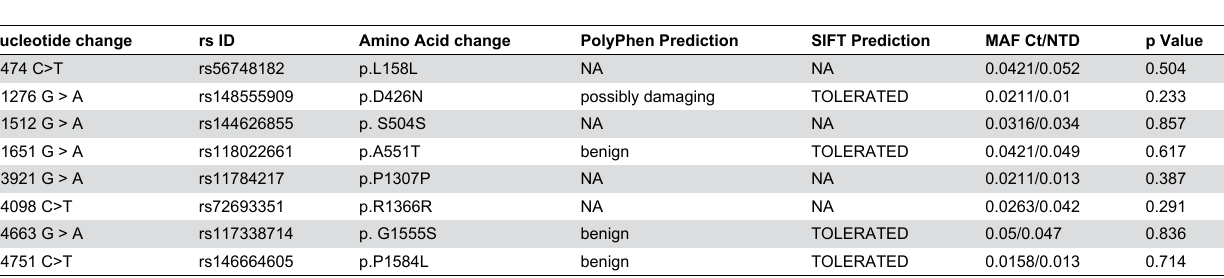
Table 3. Common Variants (MAF>=0.01) in the Coding Sequence of SCRIB Gene detected in this study.